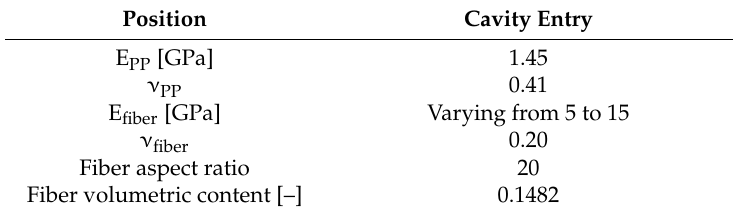
Table 2. Input parameters used to assess unidirectionally aligned short fiber moduli .